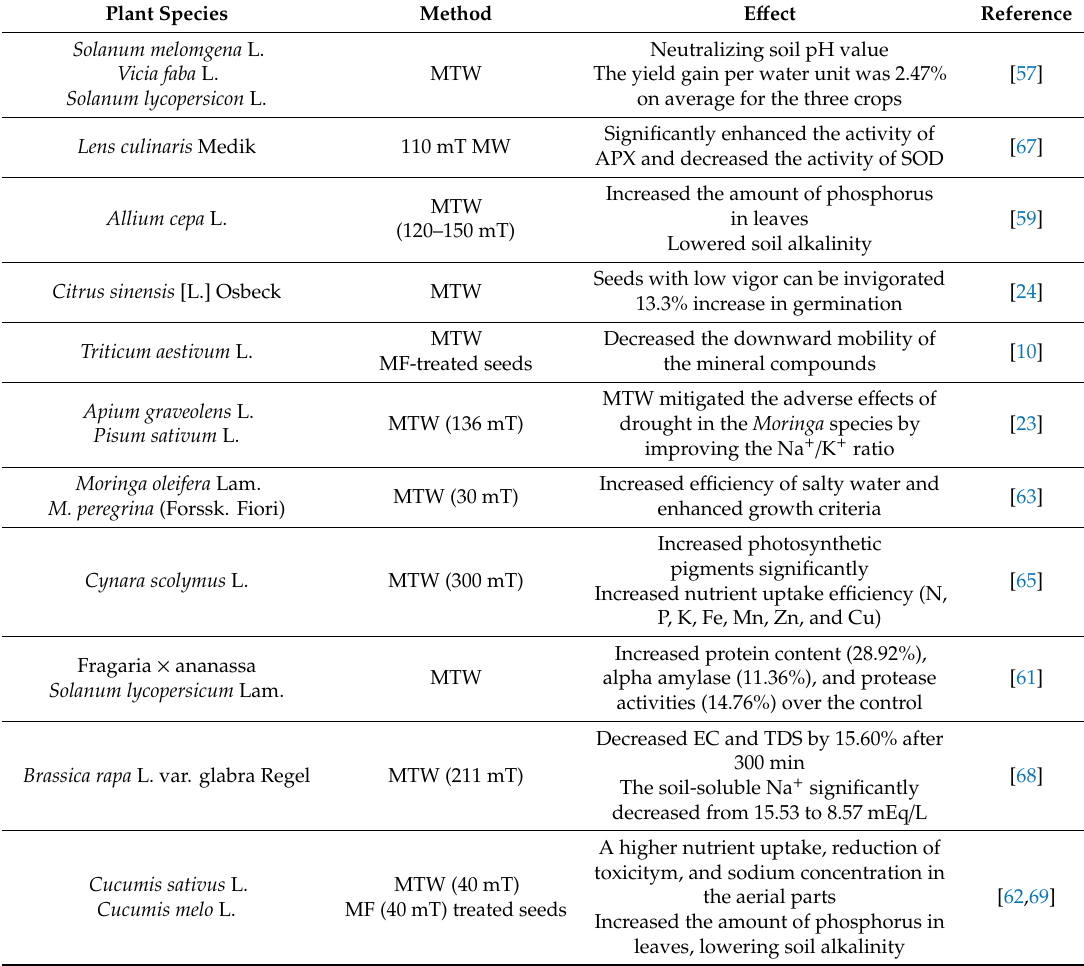
Table 2. Functions of magnetically treated water in soil and